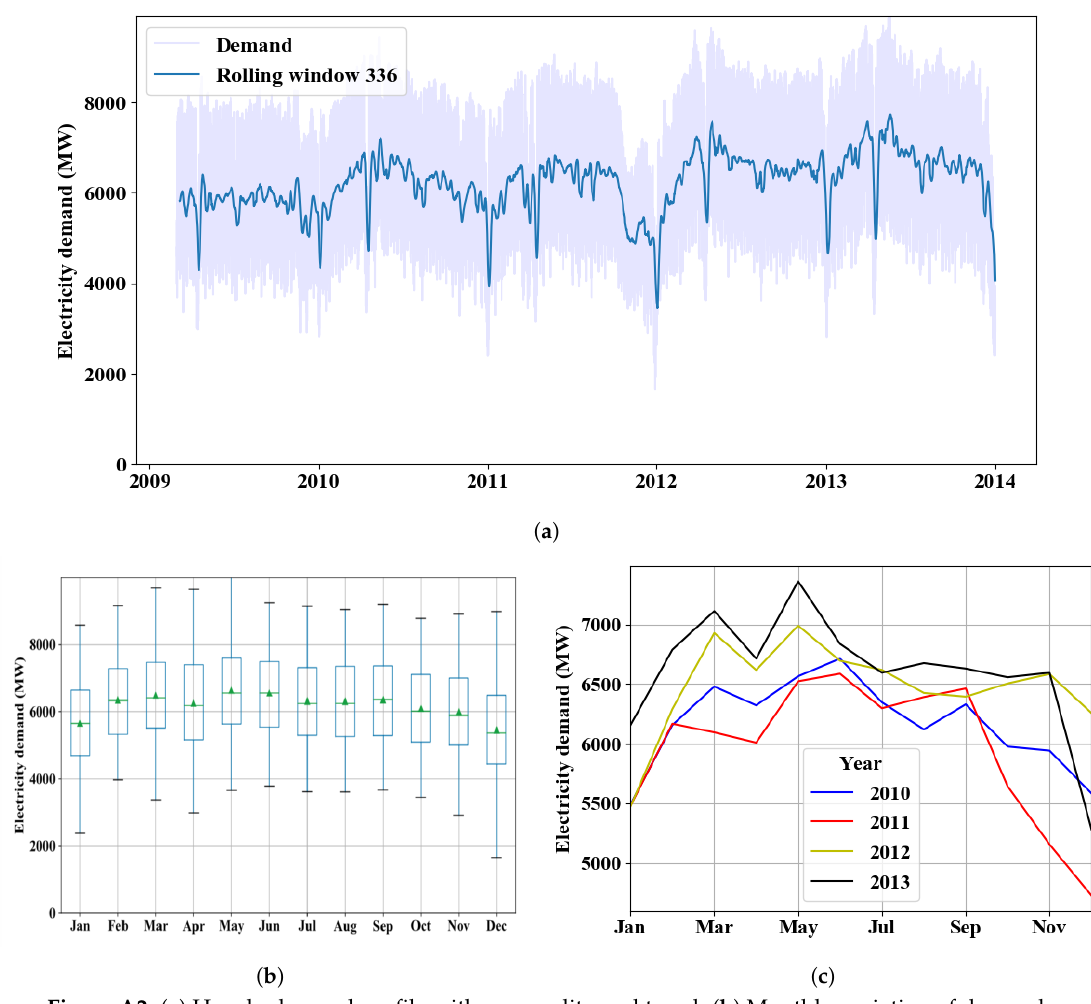
Figure A2. ( a ) Hourly demand profile with seasonality and trend. ( b ) Monthly variation of demand. ( c ) Monthly variation of demand: